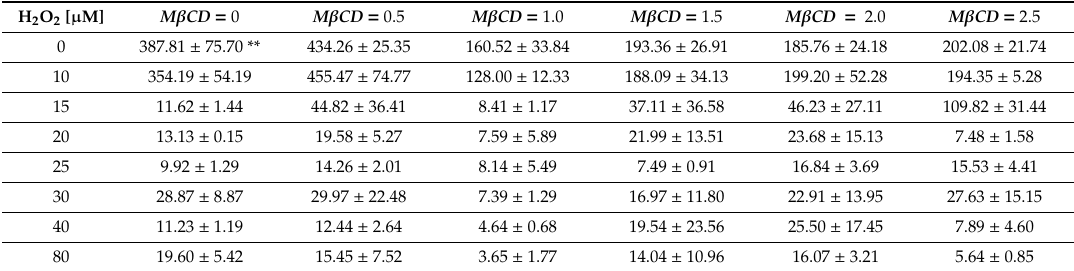
Figure 8. (Left) Diagrams of the modified p -value and reduced chi-square characterizing the linear fitting of the parameters α (a) , β (b) , γ (c) , and δ (d) , with MßCD plotted, as a function of the multiplication factor (M.F.). We identify the M.F. value, for which the corresponding p -value and reduced chi-square are optimized. The goodness of fit is shown using both the modified p -value and reduced chi-square. (Right) Here, the goodness of fit is shown using the unified measure as given by Equation (9) while it is depicted as a function of the signal-to-noise ratio of the slope b/ δ b , characterizing the linear fitting of the parameters with MßCD; (note: Both the ratio b/ δ b and the goodness of fitting are plotted as functions of the multiplication factor (M.F.)). The cases of the parameter α and γ have the optimal values of the p -value and reduced chi-square for │ b/ δ b │ < 1, so that the hypothesis of being dependent on MßCD is rejected. On the other hand, the cases of the parameter β and δ have the optimal values of the p -value and reduced chi-square for │ b/ δ b │ >> 1, thus, the hypothesis of MßCD dependence is accepted.